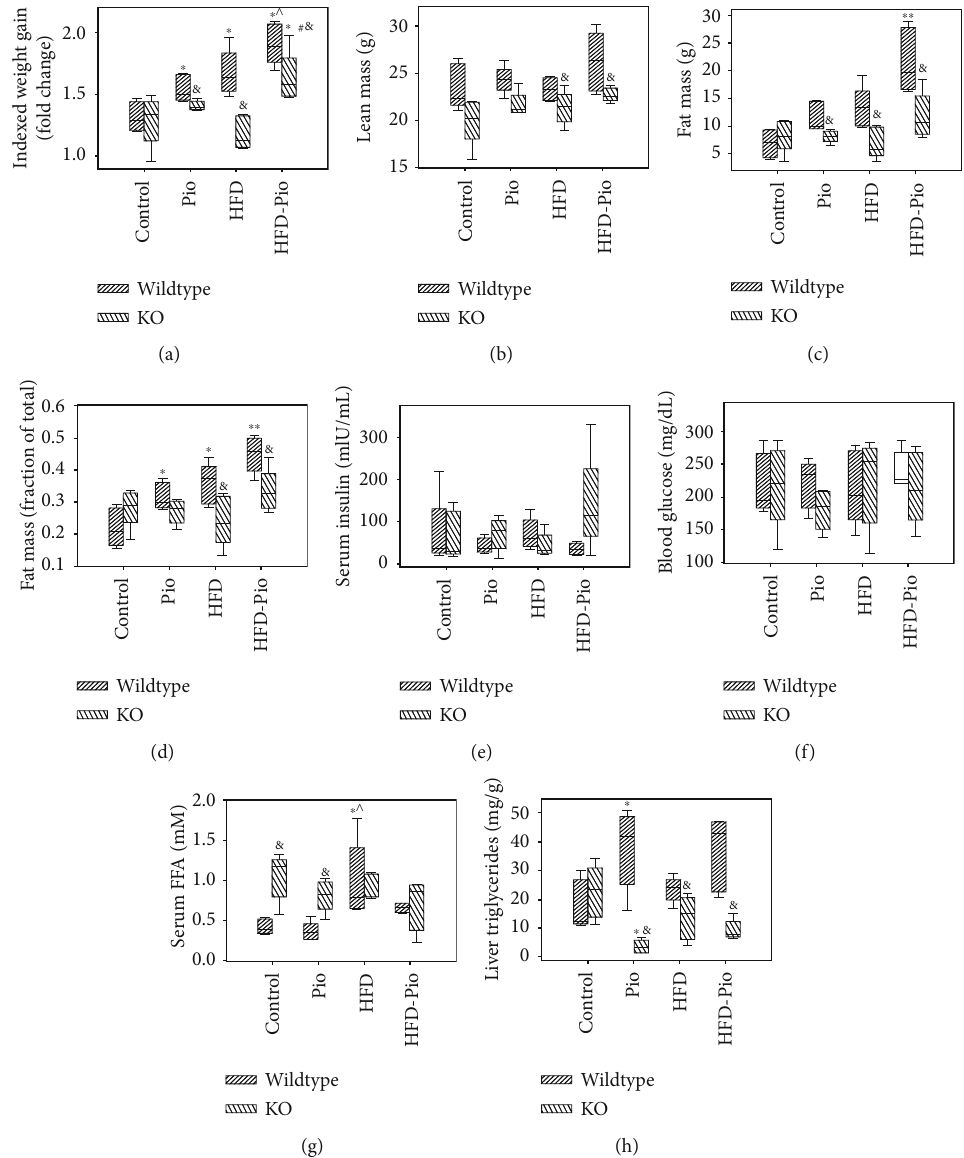
Figure 1: E ff ects of Pio on WT and PPAR γ KO mice. (a) Weight (indexed to initial weight), (b) lean mass (g), (c) fat mass (g), (d) fat mass (expressed as fraction of total mass), (e) serum insulin (mIU/mL, nonfasting a.m.), (f) blood glucose (mg/dL, nonfasting a.m.), (g) serum free fatty acids (FFA) (mM, nonfasting a.m.), and (h) liver triglycerides (mg/g liver) in wildtype (WT) and liver-speci fi c PPAR γ knockout (KO) mice given a control or high-fat diet (HFD) unsupplemented or supplemented with Pioglitazone (Pio). ∗ p < 0 : 05 vs. corresponding control diet-treated group; ∧ p < 0 : 05 vs. corresponding Pio-treated group; ∗∗ p < 0 : 05 vs. all other WT groups; # p < 0 : 05 vs. corresponding HFD- treated group; & p < 0 : 05 vs. corresponding WT